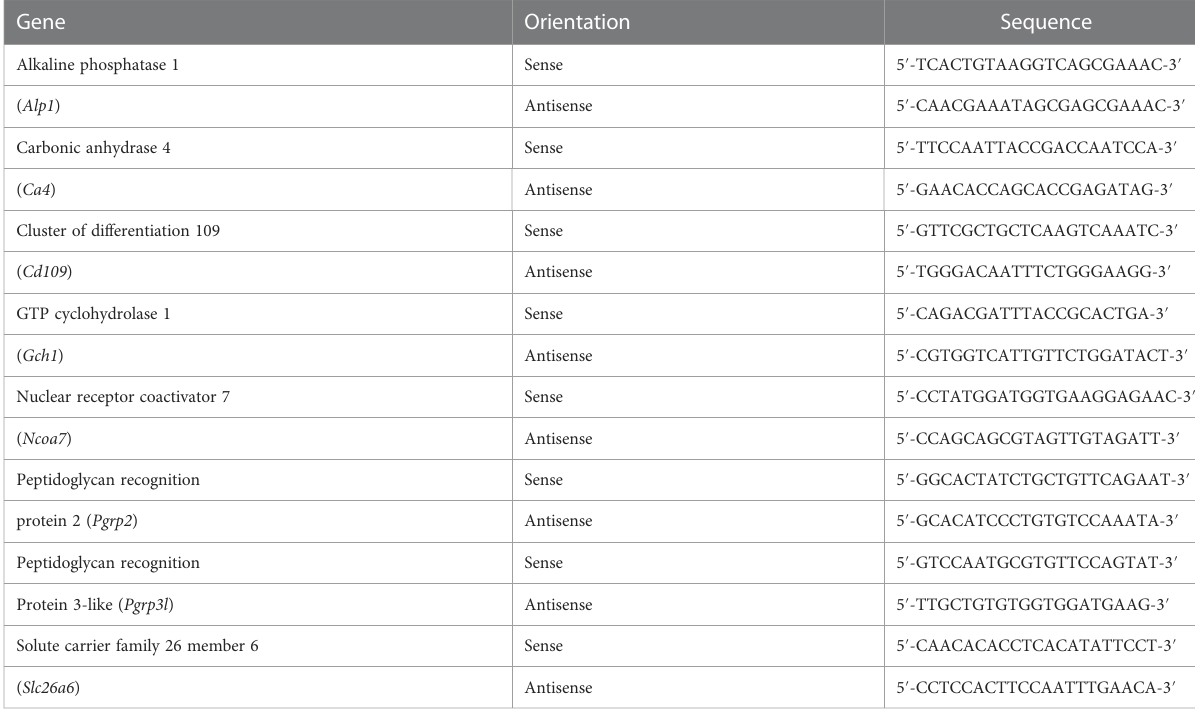
TABLE 2 The quantitative real-time PCR primers used in the present